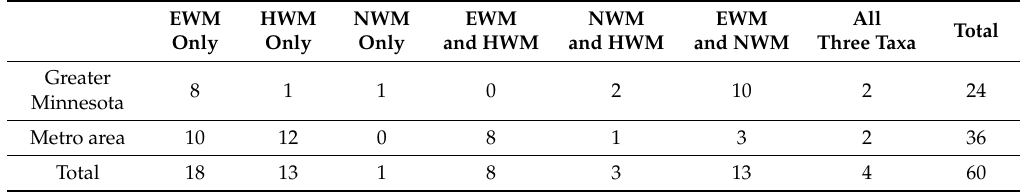
Table 1. Number of lakes with various combinations of watermilfoil taxa identified (EWM = Eurasian based on region (Greater Minnesota and Metro